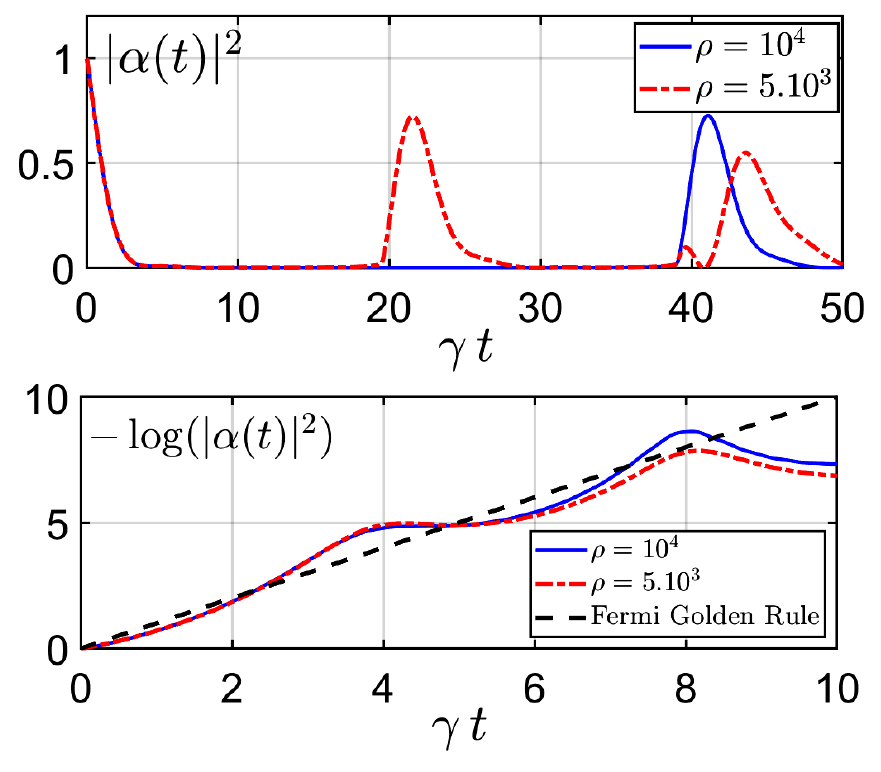
Figure 2. Survival probability in function of time in the weak coupling regime: linear–linear plot (above) and log–linear plot (below) for two values of the mode density ρ , respecting the scaling λ 2 = γ = constant (where γ is the decay factor obtained from the Fermi golden rule constraint 2 πρ · and γ t the rescaled